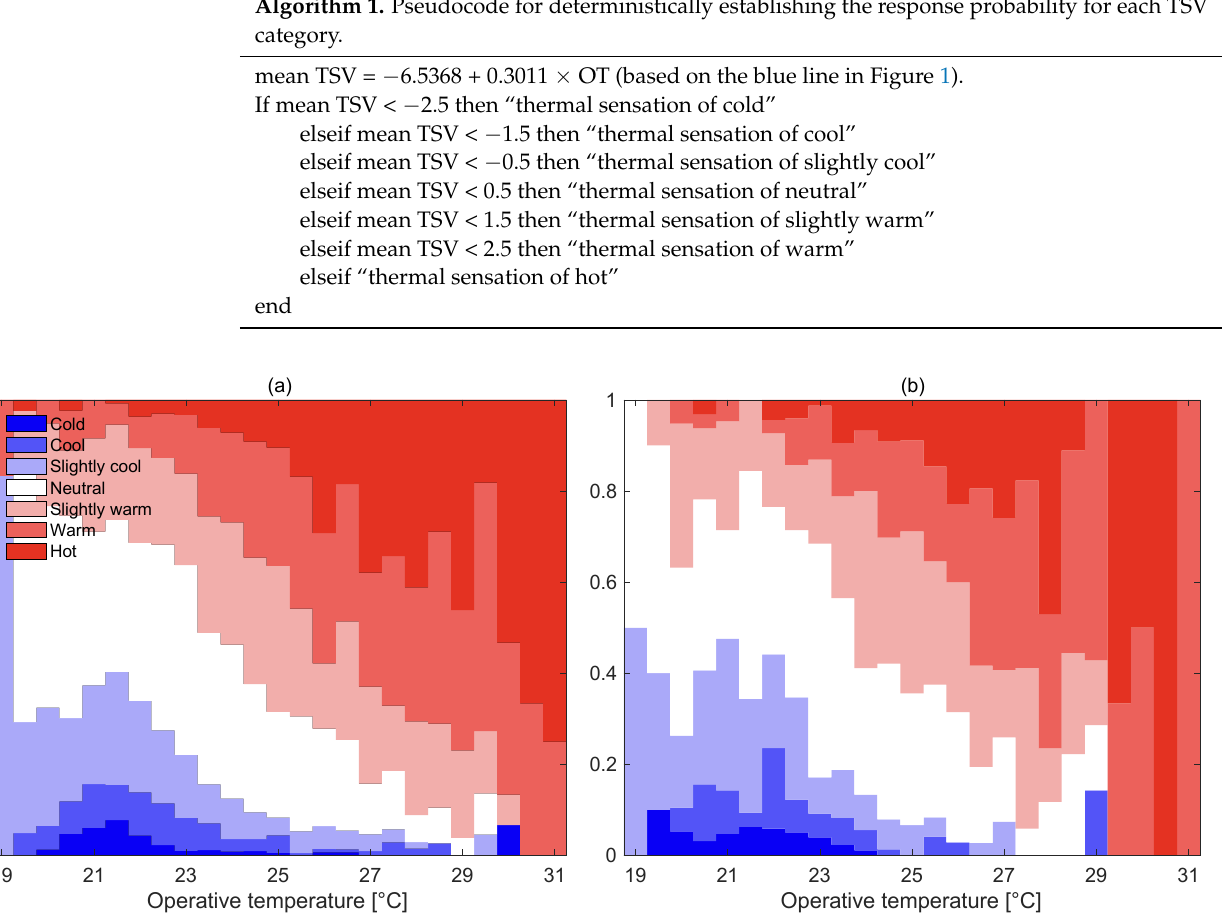
Figure 3. Observational percentage of occupants responding to each TSV category from the ( a ) training and ( b ) validation datasets. Each stacked bar was drawn using bin width of 0.5 °C.